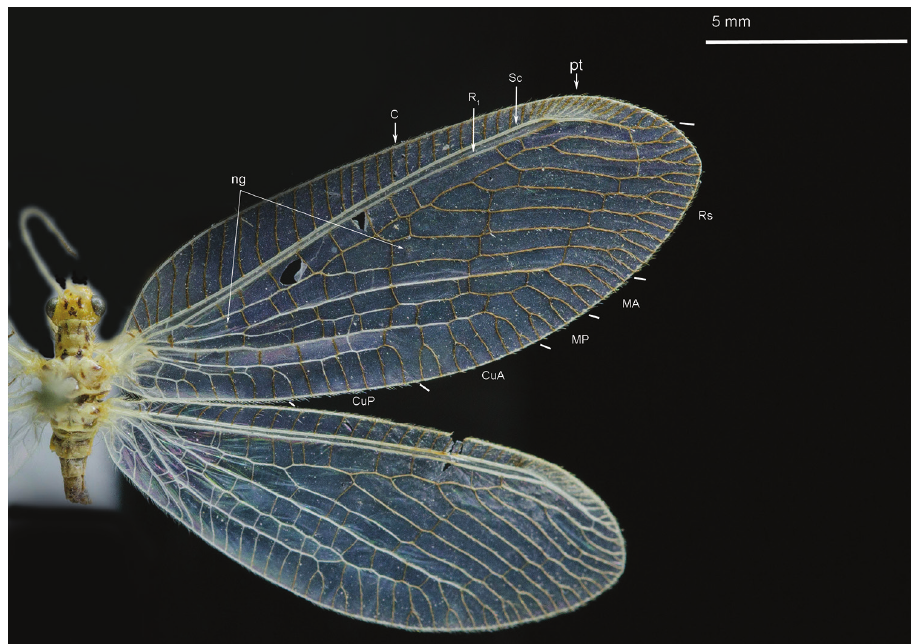
Figure 2. Wings of Heterosmylus processus sp. n. Abbreviations: ng, nygmata; pt, pterostigma.